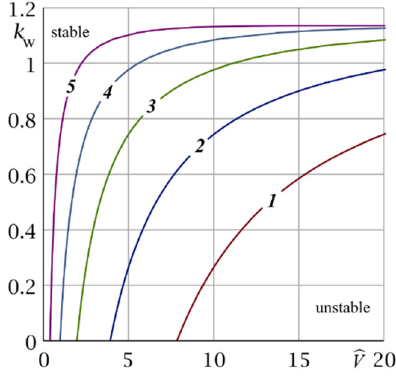
Figure 4. Boundaries between stability and instability domains of the problem solution in the ( ˆ V , k w ) plane at Bi = 100 for different values of η : 1 —0.25, 2 —0.5, 3 —1.0, 4 —2.0, 5 —5.0.